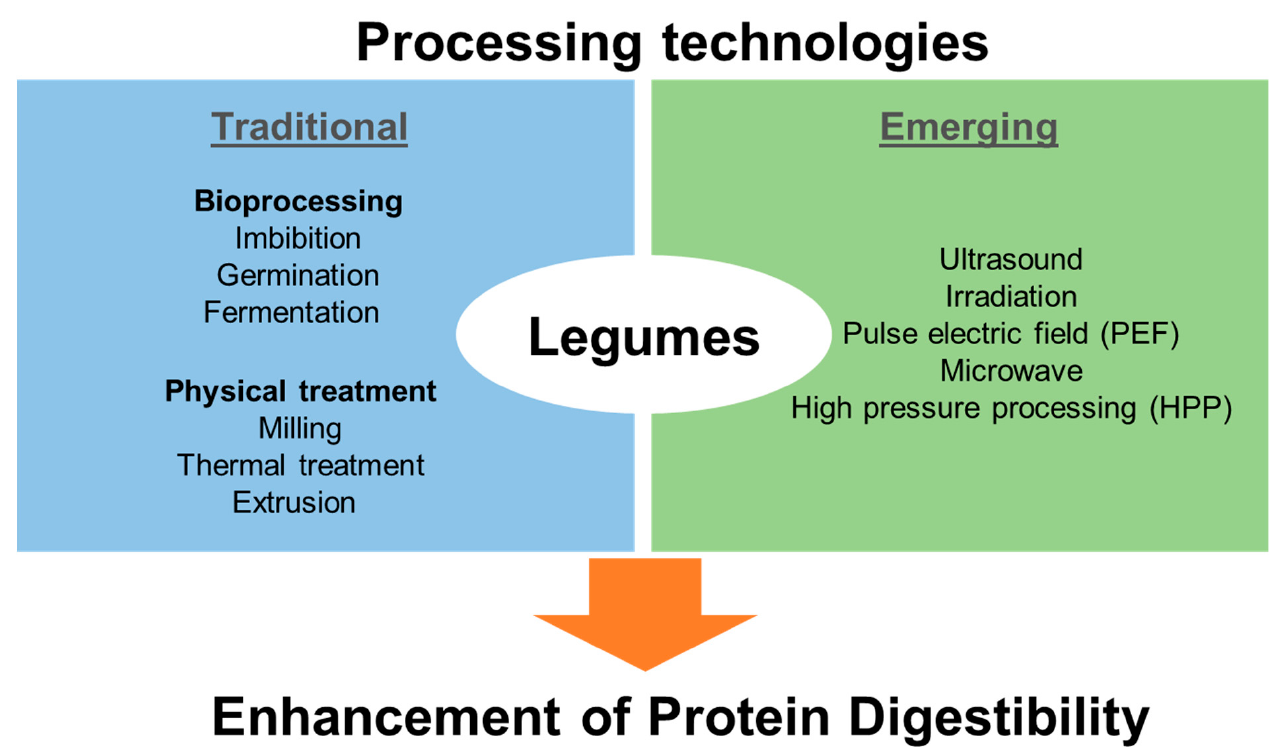
Figure 1. Overview of the major traditional and emerging food processing technologies applied for enhancement of the digestibility of legume proteins.